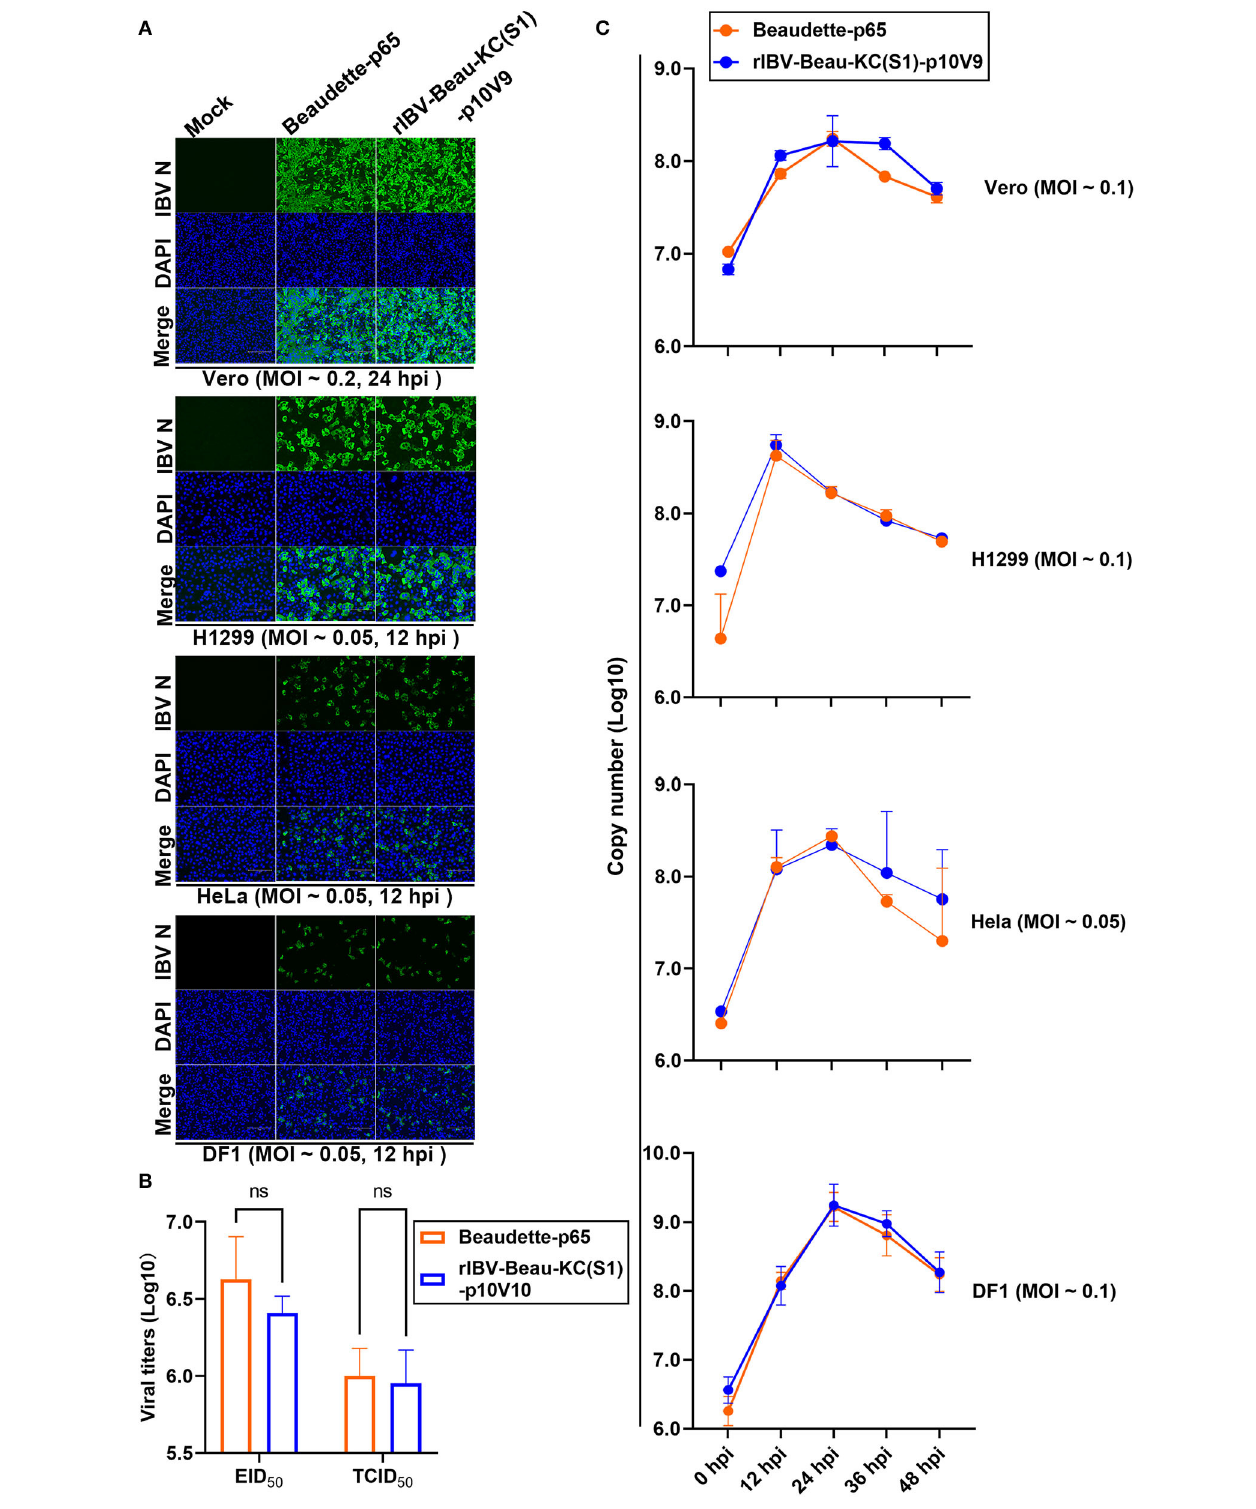
FIGURE 3 | Replication of rIBV-Beau-KC(S1) in Vero, H1299, HeLa, and DF1 cells. (A) IFA of Vero, H1299, HeLa, and DF1 cells infected with rIBV-Beau-KC(S1). Cells were infected with rIBV-Beau-KC(S1)-p10V9 and Beaudette-p65 at an MOI ∼ 0.2 or ∼ 0.05, respectively. IFA was performed with anti-IBV N monoclonal antibody and goat-mouse IgG-Fluor488 secondary antibody. (B) Determination of the maximum EID 50 and TCID 50 values of rIBV-Beau-KC(S1). Ten-fold serial dilutions of each viral